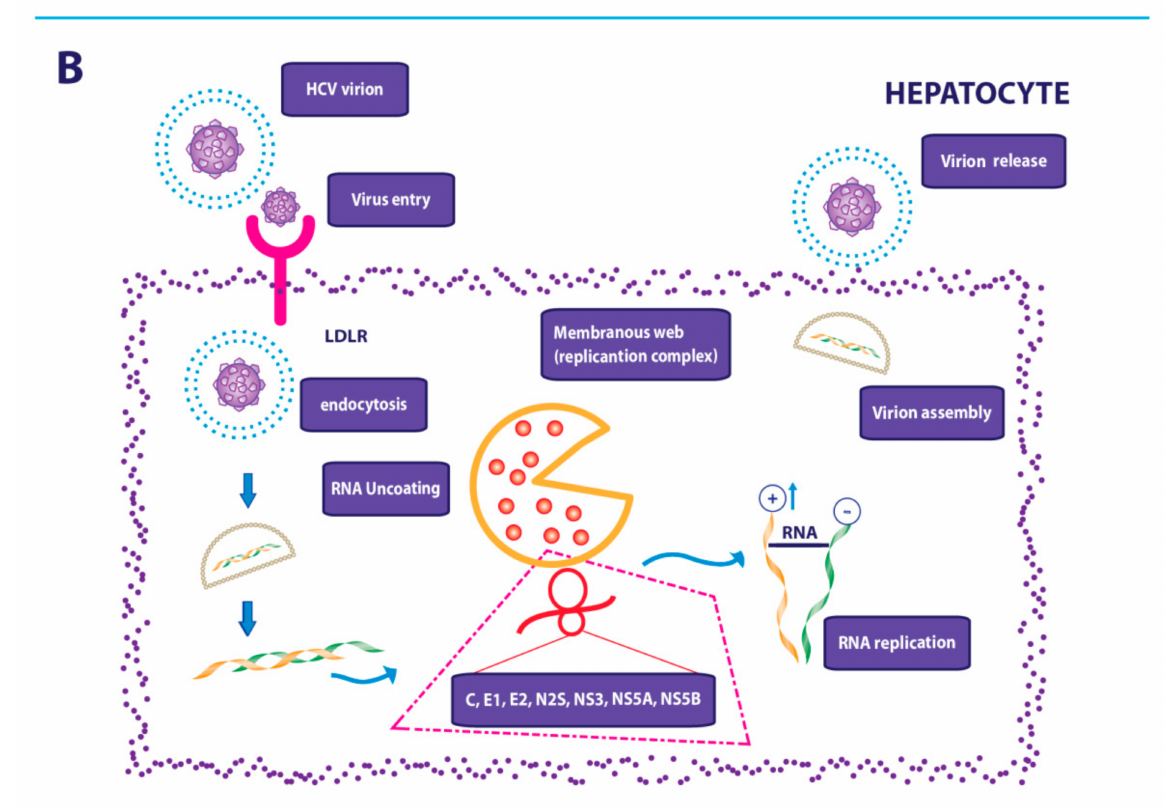
Figure 2. Viral life cycles. ( A ) Hepatitis ( B ) virus life cycle: the virus enters through the link with Na + taurocholate cotransporting polypeptide (NTCP), follows the endocytosis of the viral agent and the transport of nucleocapsid into the nucleus in which the relaxed circular DNA genome (rcDNA) is converted into covalently closed circular DNA (cccDNA). This process allows the transcription of the viral mRNA with the subsequent encapsulation of the viral protein core and the production of the double-stranded linear DNA. Through the endoplasmic reticulum, viral particles are assembled and subsequently secreted. ( B ) Hepatitis C virus life cycle: hepatitis C virus entry is mediated by the low density lipoprotein receptor (LDLR) with subsequent release of the viral genome that undergoes replication and transcription with production of a single polyprotein chain that allows the synthesis of viral proteins. They follow the assembly and release of viral particles. Table 3. Phase 3 interventional studies for HBV treatment terminated with results, drug family, and conditions. Drug